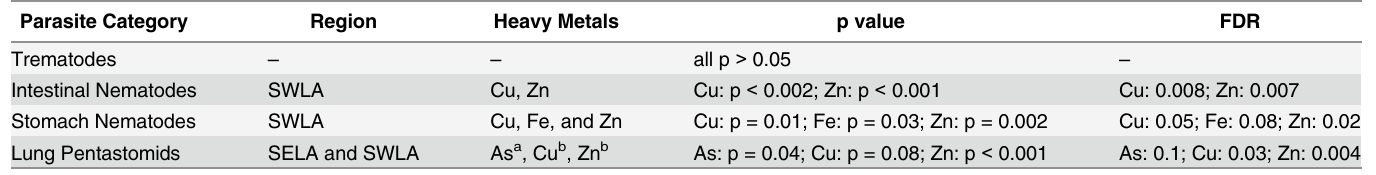
Table 6. Statistical comparison by region (SELA, SWLA, and FL) of heavy metals from different parasite groups. Statistical analyses were performed with Kruskal-Wallis chi-squared tests; region highlighted in table had significantly higher concentrations compared to other areas. Parasite